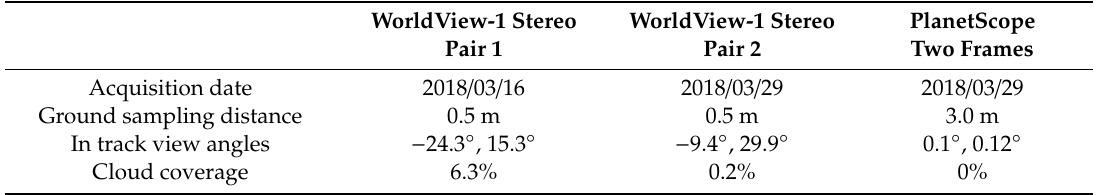
Table 1. Overview on WorldView-1 acquisitions used.